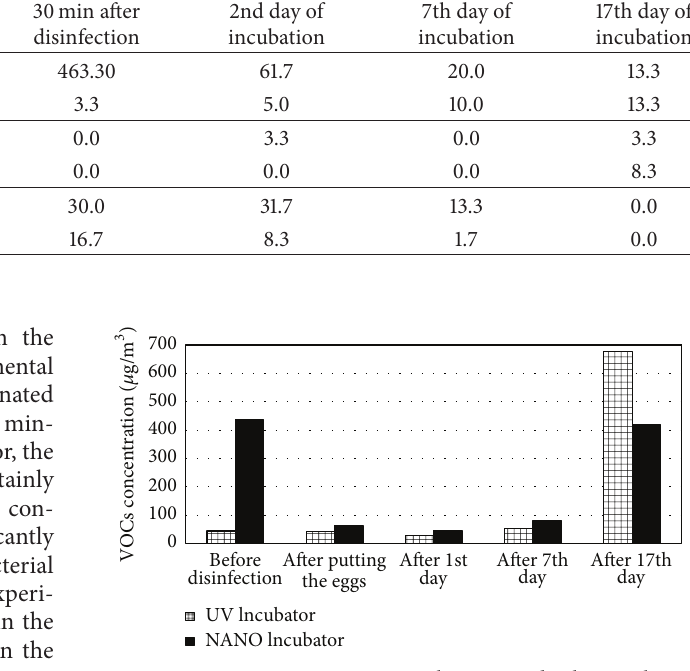
Figure 4: VOC concentrations in the air inside the incubators during the incubation [ 𝜇 g/m 3